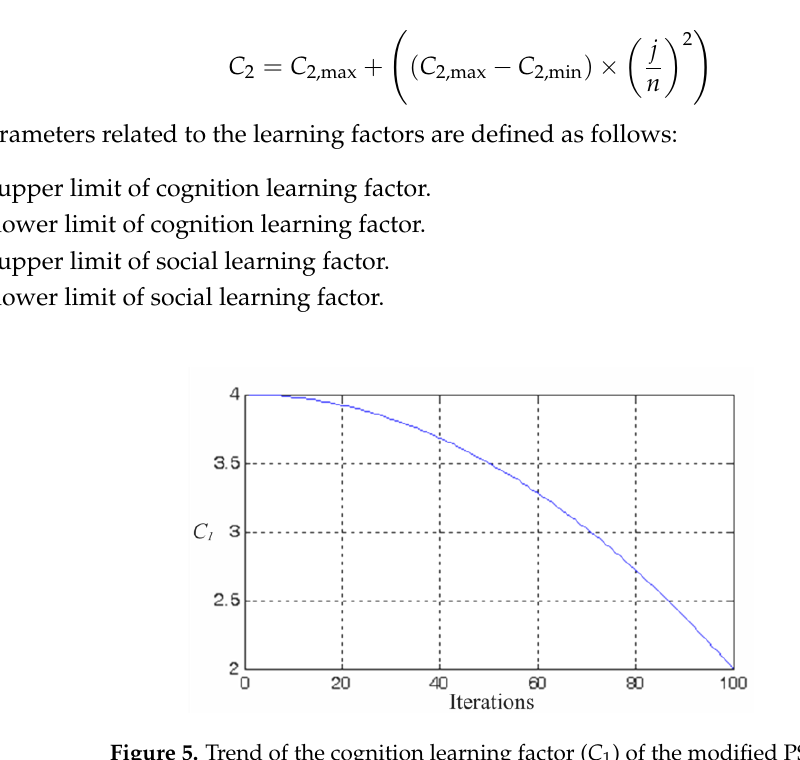
Figure 5. Trend of the cognition learning factor ( C 1 ) of the modified PSO.